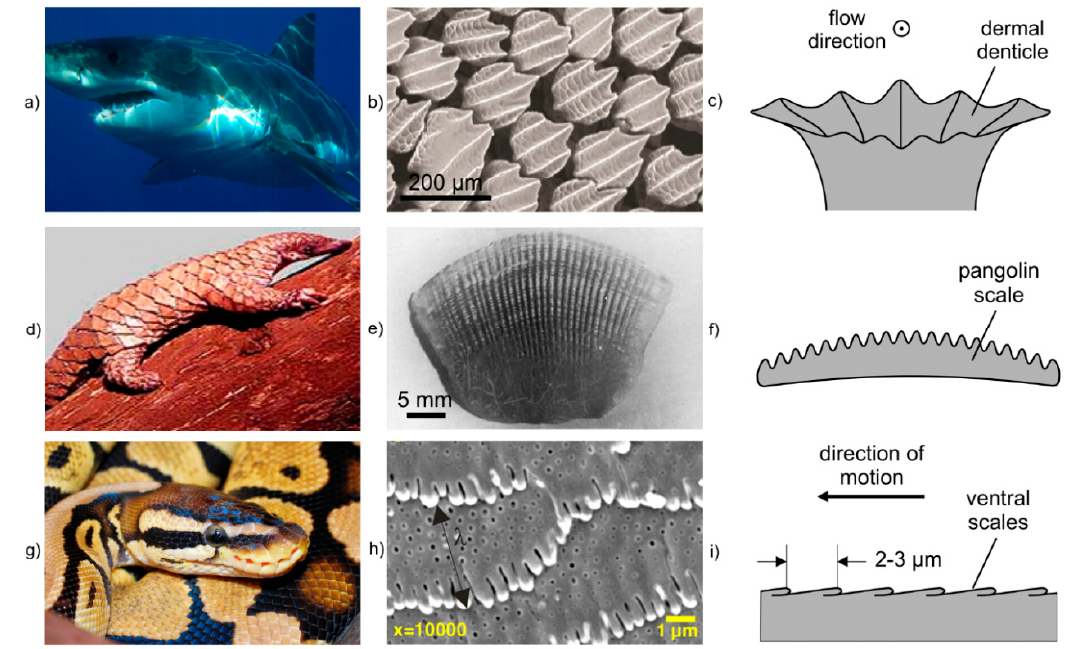
Figure 17. Examples of tribological surfaces in nature: ( a – c ) skin of sharks; ( d – f ) pangolin Manis tricuspis , and ( g – i ) Python regius ; ( b ) Adapted with permission from Wen et al . [127]; ( d ) Adapted from Ofusori et al . [128]; ( e ) Adapted from Tong et al . [129] with permission from Springer; ( h ) Reproduced with permission from Abdel-Aal and El Mansori [130] Copyright IOP Publishing. All rights reserved.